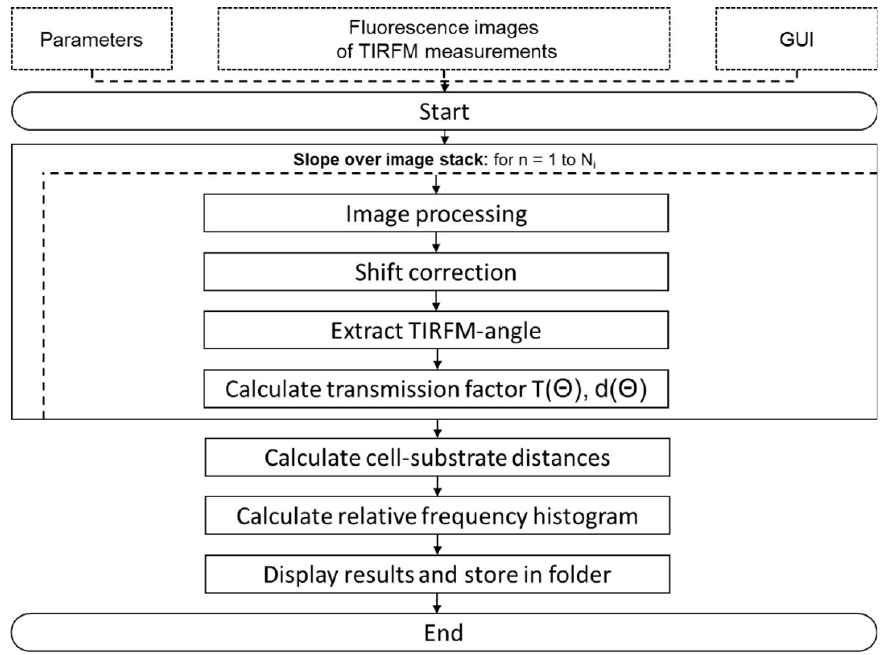
Figure 7. Flow chart of the MATLAB script used for automated cell ‐ substrate calculations (GUI = Graphical User Interface; T( Θ ) = transmission factor; d( θ ) = penetration depth of the evanescent field). Once the parameters, e.g., the corresponding metric pixel size and the refractive indices, are set and the recorded images are imported into the MATLAB environment, the code gradually starts its calculations. Images are implemented as a virtual stack with Ni corresponding to the maximum number of images for each set. Beginning with a loop covering the image stack, an algorithm is used to correct any possible shifts in the x and y directions, which may occur in individual experiments. Thus, it is ensured that every pixel addresses the same field of view of the recorded cell at various angles. Next, the angle of the recorded image is extracted from the image file name in order to calculate the transmission factor and the penetration depth, as reported